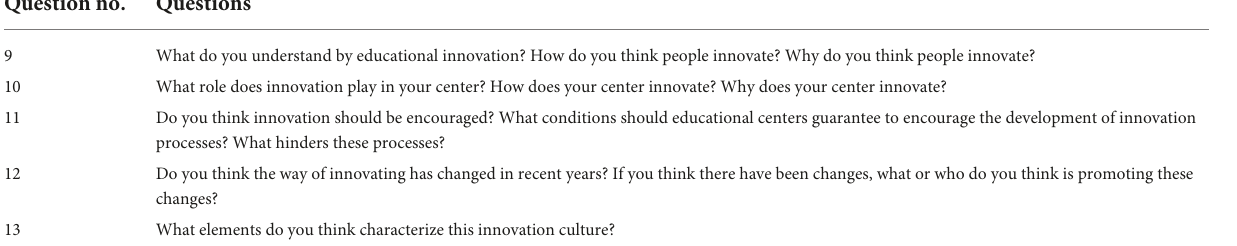
TABLE 2 Selection of questions from educational innovation and innovation culture, topic (c) of the first phase, Questionnaire 1. Question